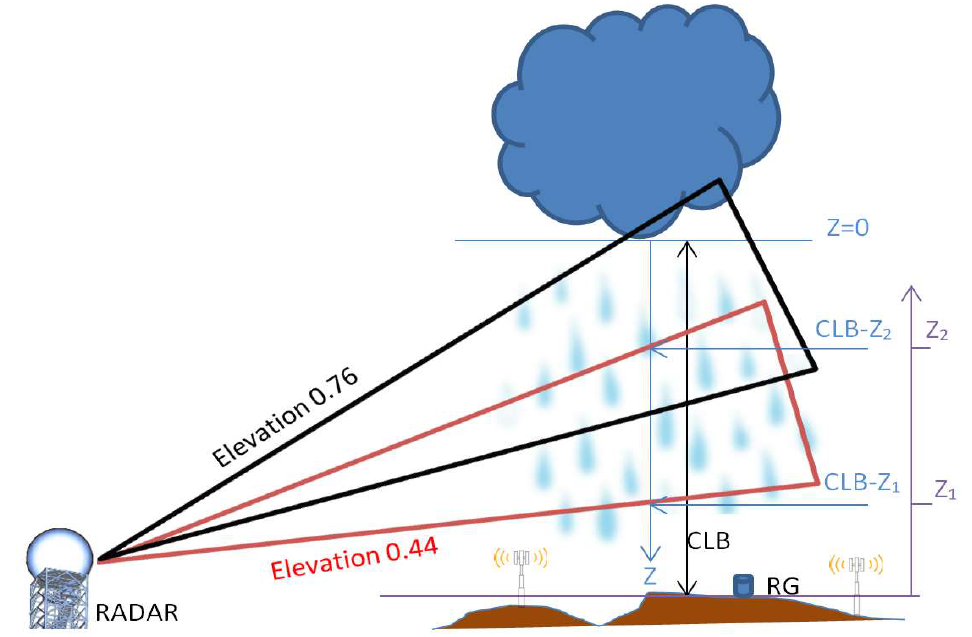
Figure 1. A diagram of the different measurement sources in respect to the vertical axis Z. The picture depicts two radar beams at different elevation levels and gives an example of the heights the elevation of 0.44 ◦ observes: Z 1 , Z 2 , in respect to the Z-axis, which actually goes from the cloud base (Cl B ) downwards to the ground. On the ground level, we can see a rain gauge (RG) and cellular antennas of the CML.